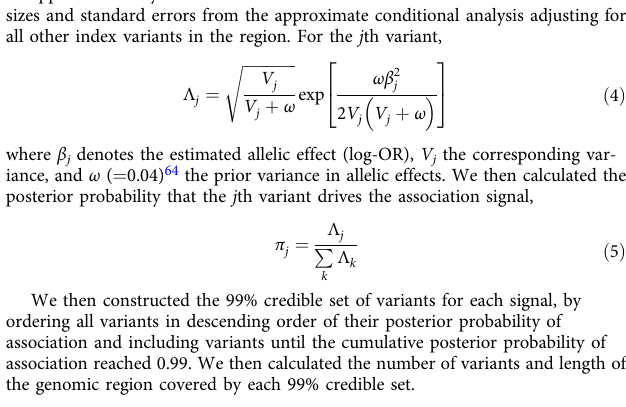
multiple linear regression to control for the potential confounding effect of body area on AT area measurements. Unless noted, no effect of body area on AT measures was found. Nile red staining of zebra fi sh adipose tissue . Five-month-old adult and post- embryonic wt sibling or rspo3 m/m fi sh were stained with Nile red and images were obtained on a Leica M205 fl uorescence stereoscope using a GFP bandpass fi lter. Standard length, body area and whole-animal Nile Red signal intensity were quanti fi ed in ImageJ/FIJI (v1.50a). To assess regional adiposity, background signal was fi rst subtracted from each image and Nile Red signal was segmented based on pixel intensity. Generalised adiposity was expressed as a % of body area; peripheral adiposity was assessed within a 400 μ m 2 ROI at the lateral SC depot (LSAT); and abdominal AT was quanti fi ed using a 400 ×200 μ m 2 ROI centred at the abdominal SC (ASAT) and pancreatic visceral (PVAT) depots. Confocal imaging of zebra fi sh adipose tissue . Adult and postembryonic wt or rspo3 m/m animals were housed in 200 ml water system supplemented with 25µM EdU for 72 h. Representative abdominal (PVAT) and peripheral (LSAT) adipose tissues were then dissected and fi xed overnight in 4% paraformaldehyde. The Click-iT imaging kit was used to detect EdU + nuclei (Life Technologies, #C10338), LipidTOX to detect lipid droplets (Life Technologies, #H34475), and Hoechst 33342 to detect nuclei (Life Technologies, #H3570). Samples were mounted, and z - stacks collected on a Zeiss LSM780 confocal microscope. Images were processed, segmented, and quanti fi ed. Allele expression imbalance (AEI) studies . AEI studies were performed as fol- lows: Brie fl y, qRT-PCR was performed on paired cDNA and genomic DNA (gDNA) samples from individuals heterozygous for both rs9491696 or rs72959041 and their corresponding transcribed (tagging) SNV using a TaqMan allelic dis- crimination assay to the tagging SNV (Life Technologies). To generate a standard curve, qRT-PCR of three pairs of gDNA homozygous for each of the two alleles mixed at different ratios (30:70, 40:60, 50:50, 60:40 and 70:30) were performed concurrently. The standard curve was generated from the mean observed % of effect allele (EA), which tags the WHRadjBMI risk allele. The observed % EA from each experimental gDNA and cDNA sample was estimated from the standard curve. Under idealised conditions, the observed % EA from heterozygous gDNA would be 50%. Signi fi cant deviation in observed % of EA in cDNAs from that of gDNA indicates the presence of AEI in RSPO3 expression.